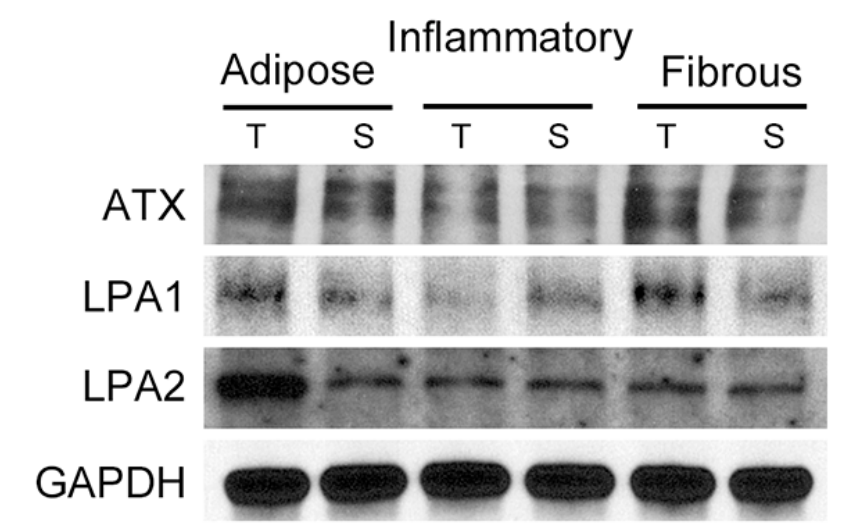
Figure 2. Expression of ATX-LPA signaling-related proteins according to breast cancer stroma type in Western blot. ATX and LPA1 expressions had no significant differences among stroma types or cancers around them. However, level of LPA2 of tumor around adipose stroma was much higher than the other tumors surrounded by inflammatory or fibrous stroma. T, tumor; S, stroma.